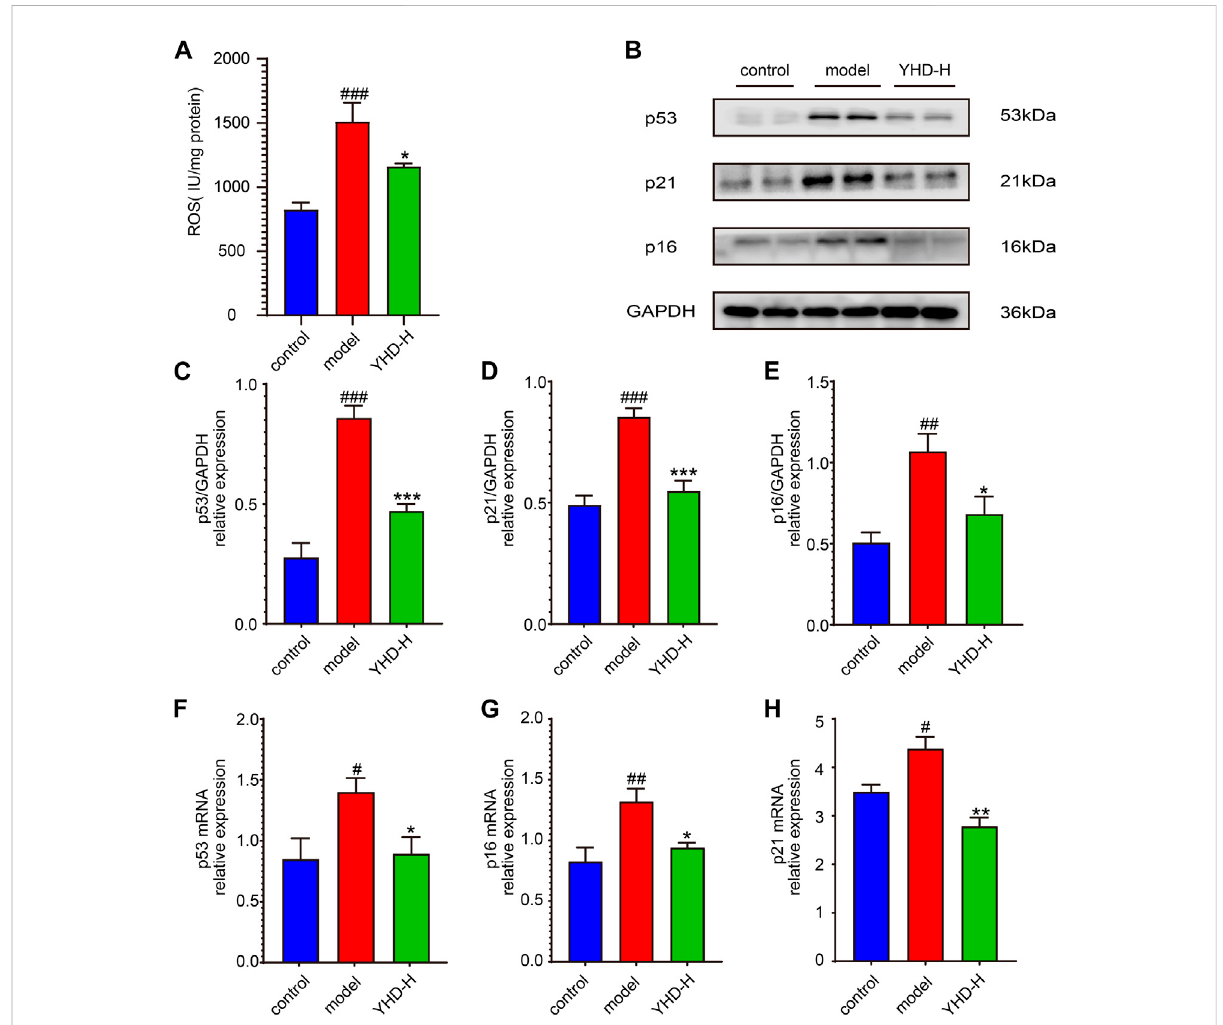
FIGURE 7 High-dose YHD inhibited cellular senescence. (A) the relative content of ROS in the lung tissue. (B) Western blotting of p53, p21, and p16 in the lung of fi brotic rats. (C – E) The relative protein expression of p53, p21, and p16 in the lung. (F – H) The relative gene expression of p53, p21, and p16 in thelung by rt-qPCR. Data were presented as the means ± SEM ( n = 6each group). # p < 0.05, ## p < 0.01, ### p < 0.001, compared with thecontrol group; * p < 0.05, ** p < 0.01, *** p < 0.001, compared with the model